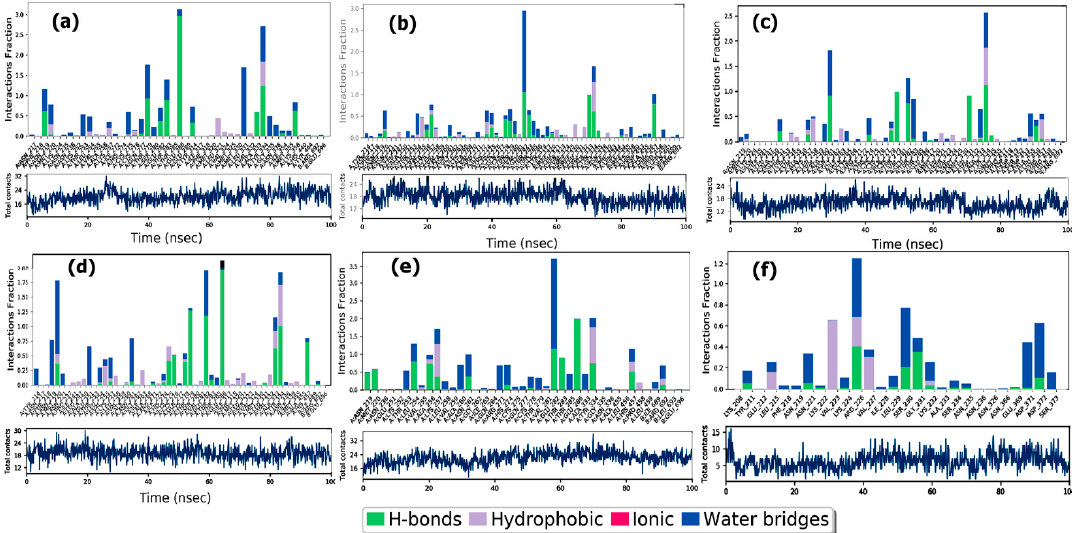
Figure 12. Protein ligand contacts of PPAR α -ligand complexes. ( a ) with RMAPep conjugate (top); total contacts during the simulation with RMAPep conjugate (bottom); ( b ) with RMAMut1 conju- gate (top); total contacts with RMAMut1 conjugate (bottom); ( c ) with GLAMut1 conjugate (top); total contacts with GLAMut1 (bottom); ( d ) with GLAMut2 conjugate (top); total contacts with GLAMut2 (bottom); ( e ) with CGAMut4 conjugate (top); total contacts with CGAMut4 (bottom); ( f ) with CSAMut4 conjugate (top); total contacts with CSAMut4 (bottom).